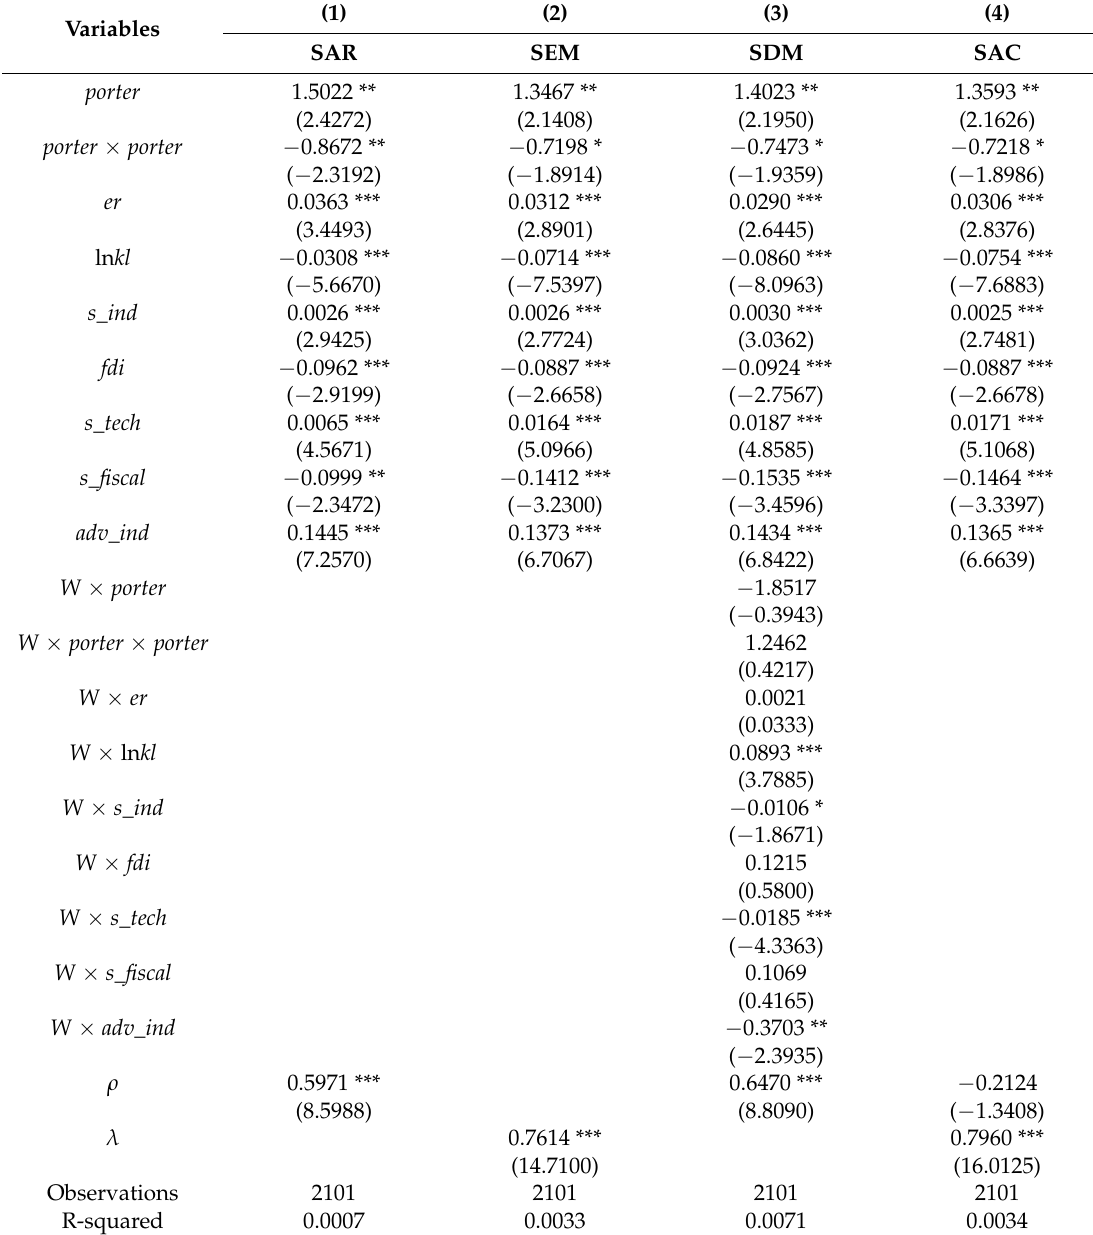
Table 7. Spatial effects of the Porter externality on